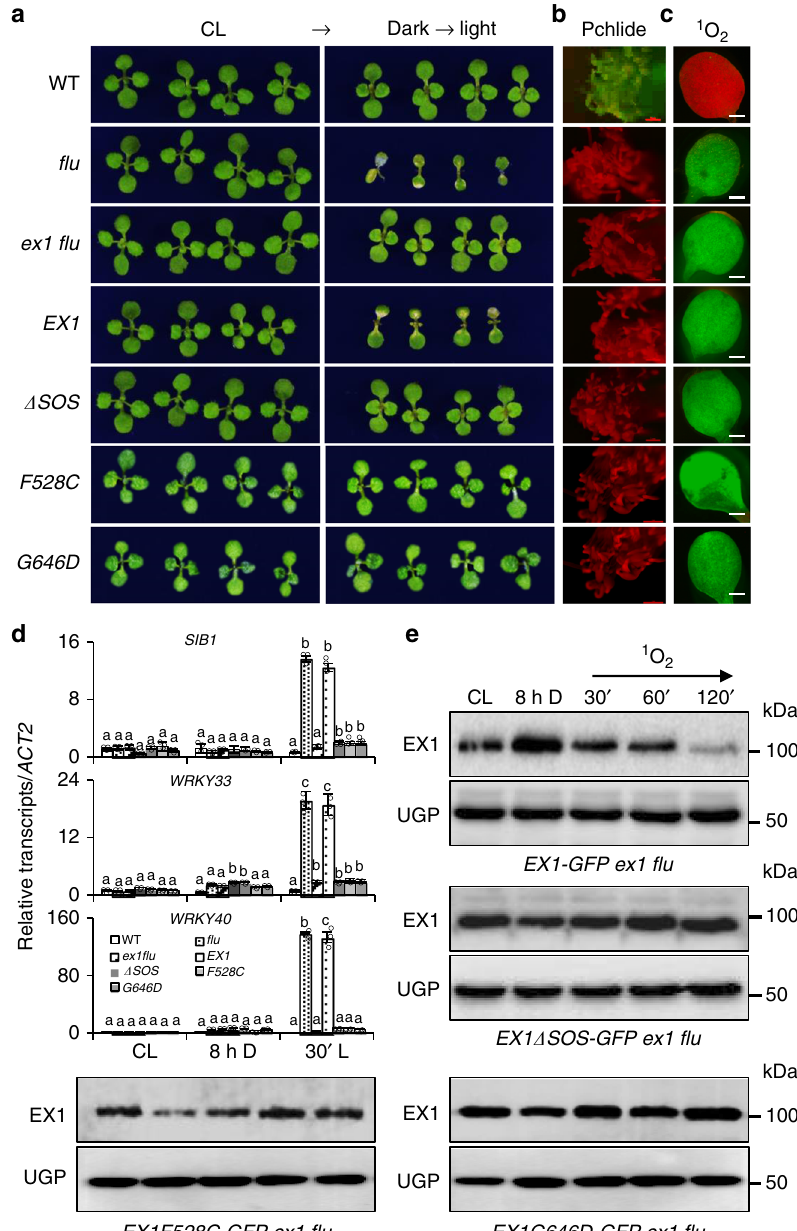
Fig. 5 The SOS domain is essential for EX1 degradation and 1 O 2 signaling. a EX1 Δ SOS-GFP, EX1F528C-GFP, and EX1G646D-GFP are unable to complement ex1 fl u . Seedlings of WT, fl u , ex1 fl u , EX1-GFP ex1 fl u ( EX1 ), EX1 Δ SOS-GFP ex1 fl u ( Δ SOS ), EX1F528C-GFP ex1 fl u ( F528C ), and EX1G646D-GFP ex1 fl u ( G646D ) grown for 5 days under CL were shifted to LD conditions for 3 days. Seedlings grown under CL for 8 days serve as controls. b Pchlide accumulation in etiolated seedlings. c Singlet oxygen sensor green (SOSG) fl uorescence and d expression of SORGs were determined as shown in Fig. 3c, d. ACT2 was used as an internal control. Data represents the mean of three independent biological replicates. Error bars indicate standard deviation. Lower case letters indicate statistically signi fi cant differences between the mean values ( P < 0.05, one-way analysis of variance with post hoc Tukey ’ s Honest Signi fi cant Difference test). e Deletion or modi fi cation of the SOS domain prevents the EX1 degradation. Total protein isolated from 5-day-old seedlings initially